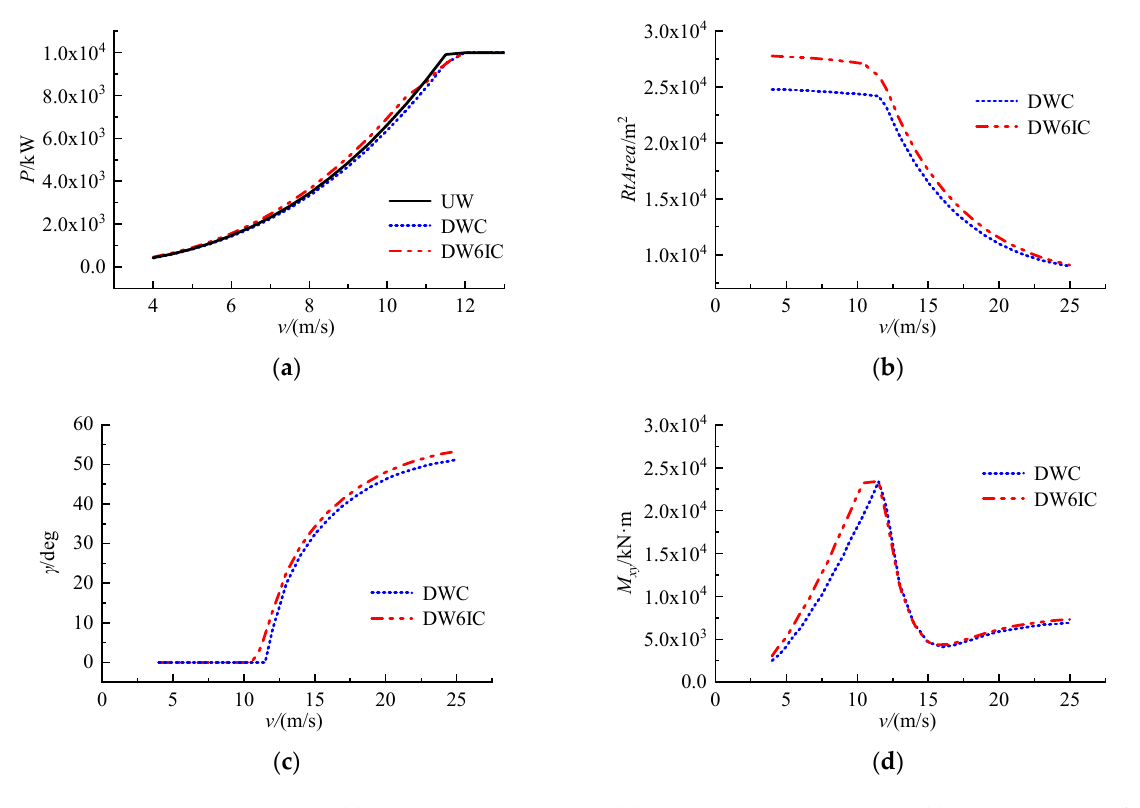
Table 4. Case simulation results.